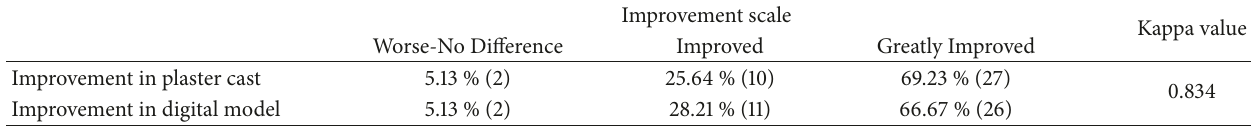
Table 2: Agreement of the categorization of improvement in occlusion with respect to PAR scores. Improvement scale